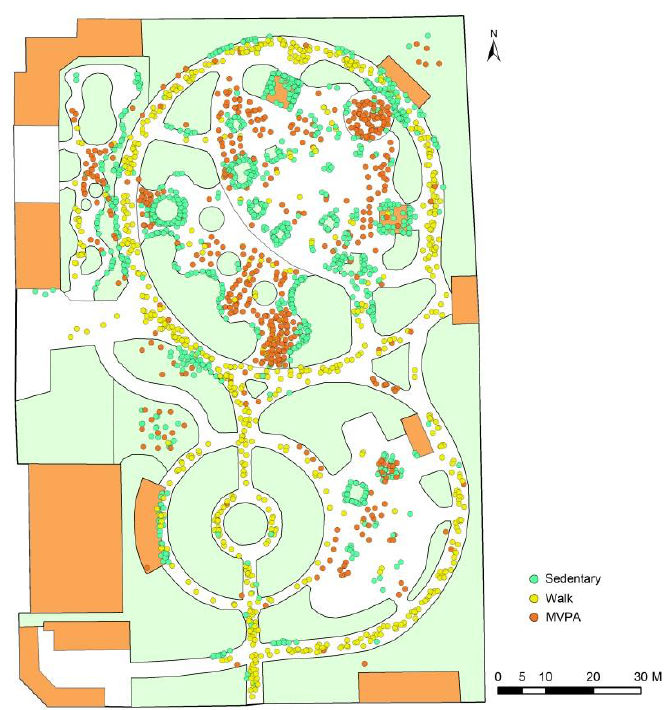
Figure A1. Behavior map of Songhe Park showing the distribution of users (the data were from nine rounds of observations: morning, noon and afternoon, three times each).